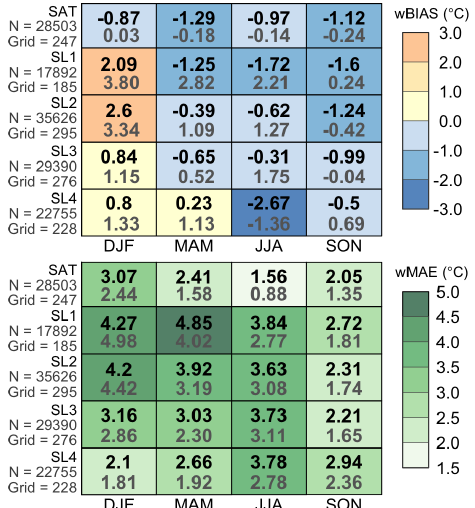
Figure 2. Monthly deviations of ERA5L soil temperature over per- mafrost regions. Monthly soil temperature is first simulated for each depth and grid, and then the comparison is conducted for each sea- son by averaging the MAE of all grids. Numbers in black at the top of each cell are for all permafrost regions. Numbers at the bottom of each cell in gray are limited to results from Russia and Alaska to permit comparison with the results of Melton et al. (2019). SAT is the near-surface air temperature.